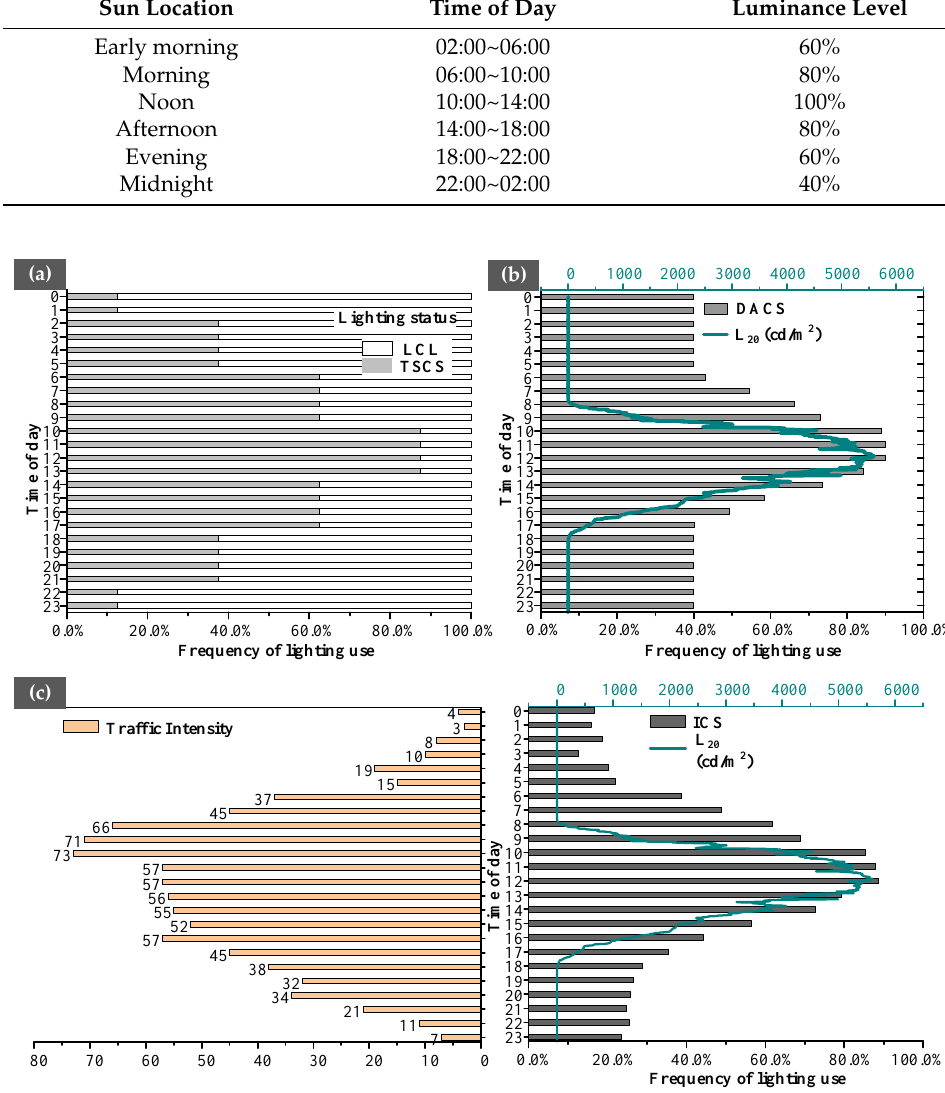
Figure 3. Hourly lighting luminance level for various control strategies.